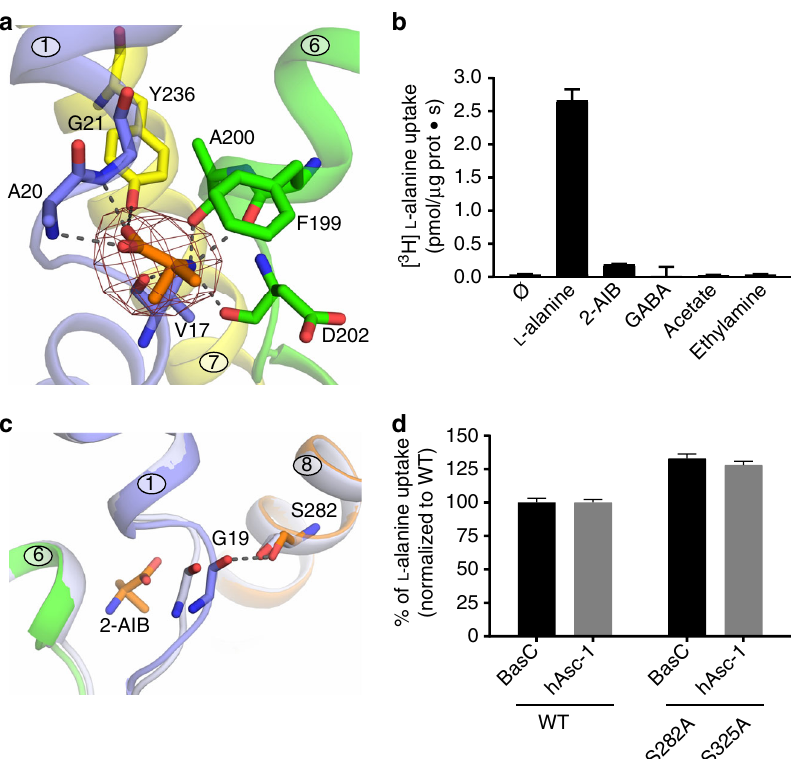
Fig. 3 Structure of the amino acid binding site and substrate-induced fi tting. a View of the bound 2-AIB ligand, showing the POLDER electron density map contoured at 3 σ , dark red. Distances between atoms of the substrate and BasC residues compatible with H bonds are indicated (dashed lines). b 10 μ M [ 3 H] L -alanine exchange (pmol μ g protein − 1 s − 1 ) into BasC PLs containing 4 mM of the indicated compounds. c Binding of 2-AIB displaces Gly 19 in the BasC apo structure (light gray) to H bond distance (dashed line) with Ser 282 in the holo structure (rainbow). d 10 µ M [ 3 H] L -alanine/4 mM L -alanine exchange by BasC reconstituted in proteoliposomes (PLs) (black bars) and transport of 10 µ M [ 3 H] L -alanine in HeLa cells by human Asc-1 (hAsc-1) (gray bars). Wild-type (WT) and the indicated homologous mutants of BasC and hAsc-1 were studied. Transport is normalized to the corresponding wild-type values. In b, d , data (mean ± s.e.m.) from 3 independent experiments are shown. Source data are provided as a Source Data fi le